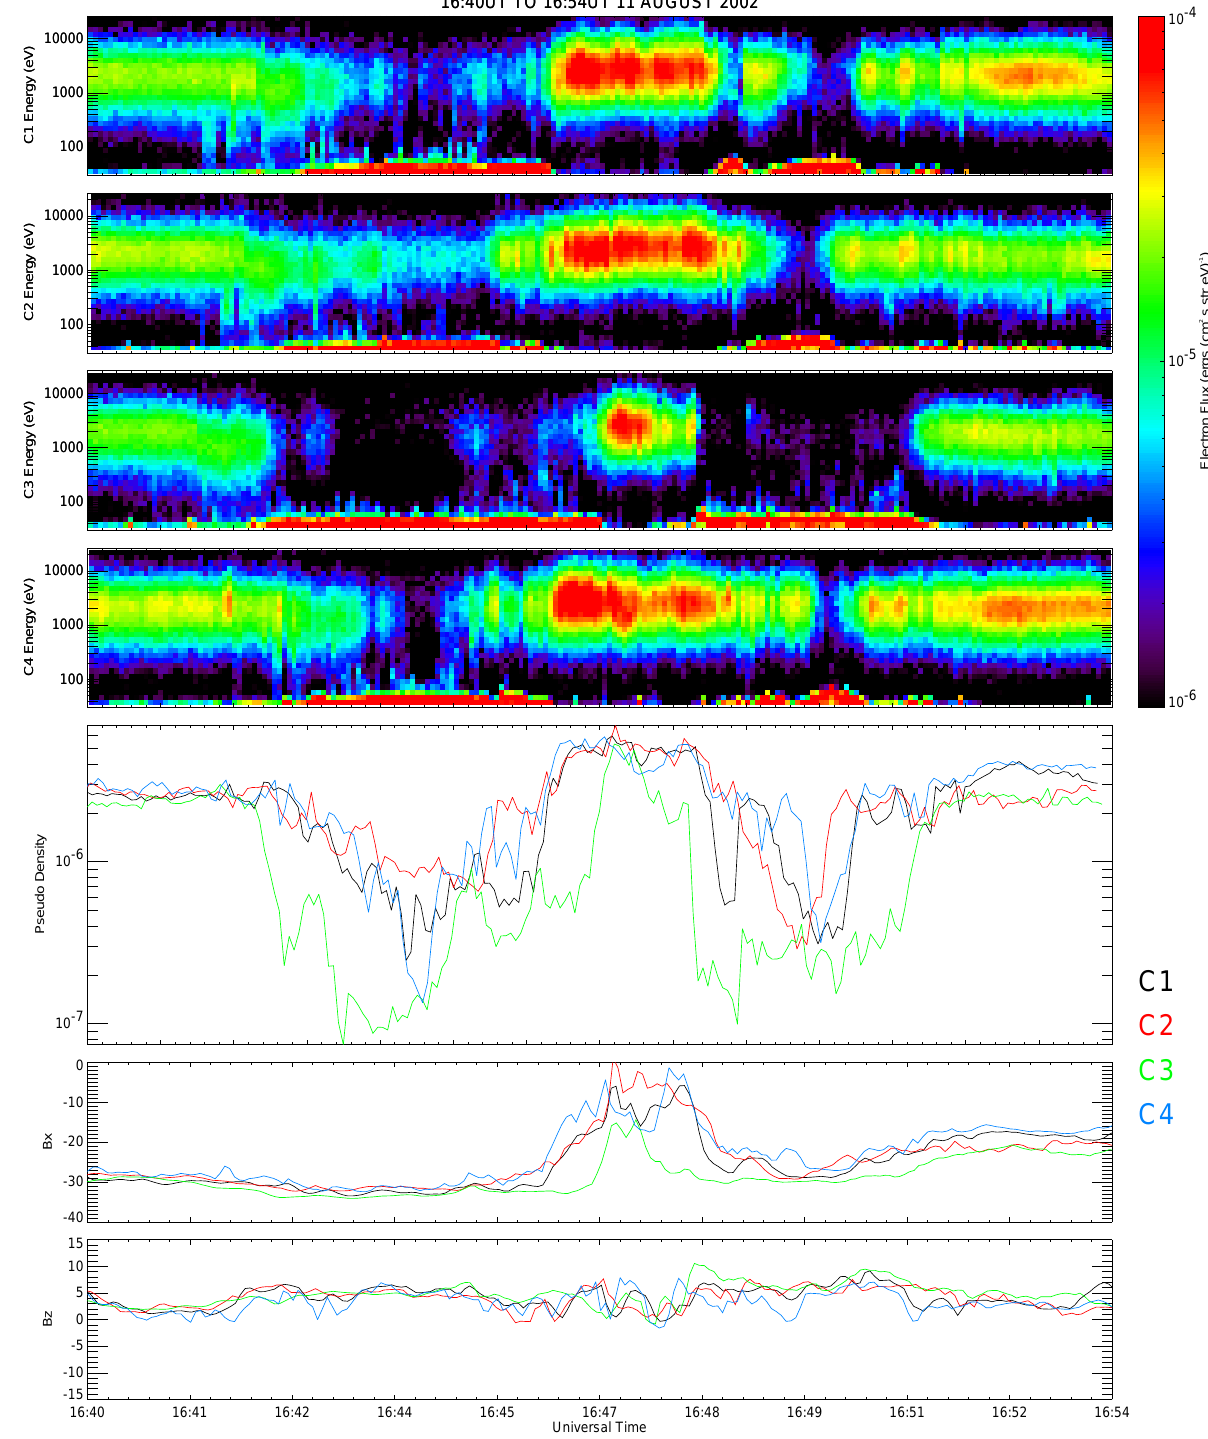
Fig. 7. Electron energy - differential flux spectrogram for C1 to C4 in the first four panels showing data summed over all pitch angles for the interval 16:40 UT to 16:54 UT on 11 August 2002. Plasma sheet plasma is punctuated by two periods in the lobe. The density proxy (summed over all electrons above ∼ 100eV) is plotted in panel 5 using black, red, green and blue for C1 to C4, respectively. The B X and B Z components of the magnetic field measured at C3 are shown in panels 6 and 7, showing a magnetic field re-arrangement at ∼ 16:47